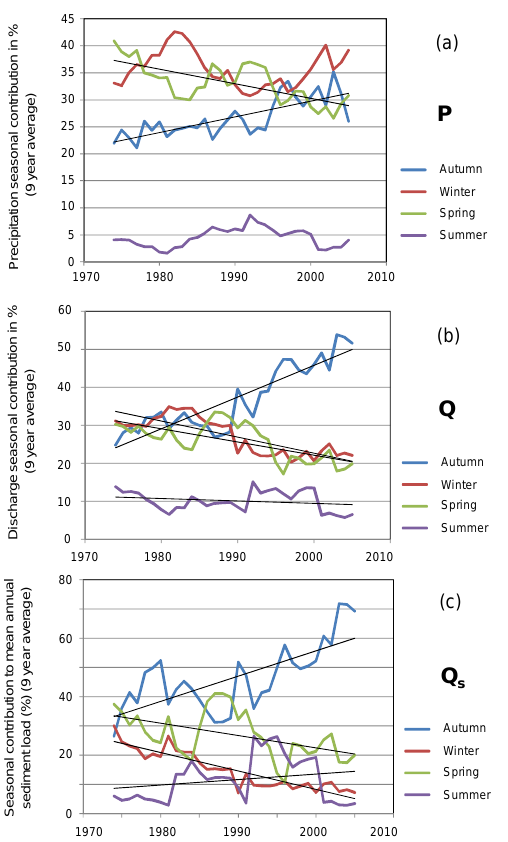
Figure 11. Trends of the seasonal indexes of precipitation (a) , dis- charge (b) and sediment discharge (c) in the Wadi Abd basin.